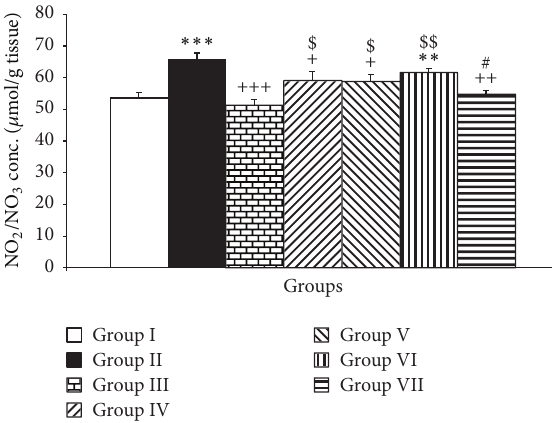
Figure 5: The effects of PTU, Vit E, pioglitazone, and rosiglitazone on cerebellar CAT. Data are presented as mean ± SEM; 𝑛 = 7 . ∗ 𝑃 < 0.05 , ∗∗ 𝑃 < 0.01 , and ∗∗∗ 𝑃 < 0.001 versus group I; + 𝑃 < 0.05 and +++ 𝑃 < 0.001 versus group II; $$$ 𝑃 < 0.001 versus group III. The data from different treatment groups were compared by using one way ANOVA followed by post hoc LSD test. Group I (control), the animals received drinking water; group II, the animals received 0.05% propylthiouracil (PTU) in drinking water; besides PTU, the animals in groups III, IV, V, VI, and VII were injected with 20mg/kg vitamin E (vit E), 10 or 20 mg/kg pioglitazone, and 2 or 4mg/kg rosiglitazone, respectively.